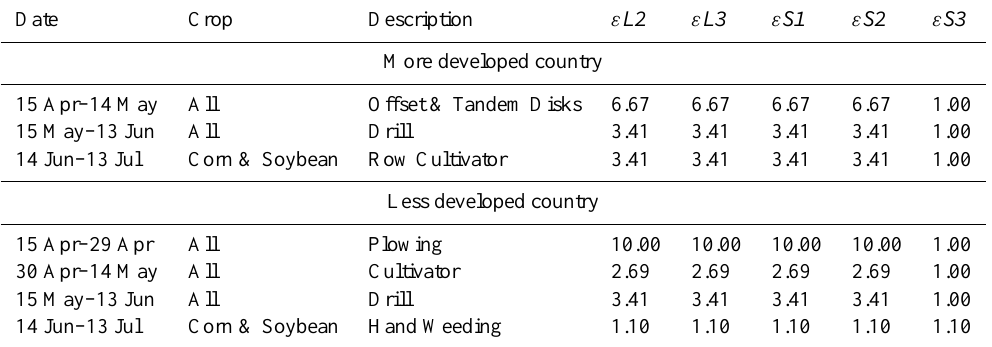
Table 4. CLM’s global annual cultivation events and corresponding decomposition enhancement factors for litter and soil C (pools as in Table 2) in different